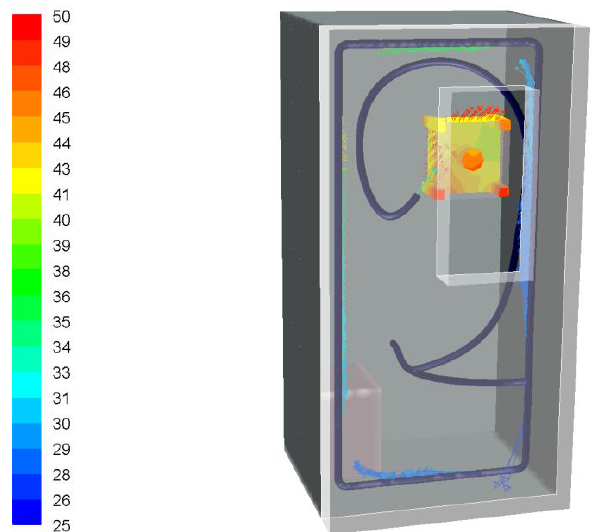
Figure 7. Temperature profile inside the camera box (°C).